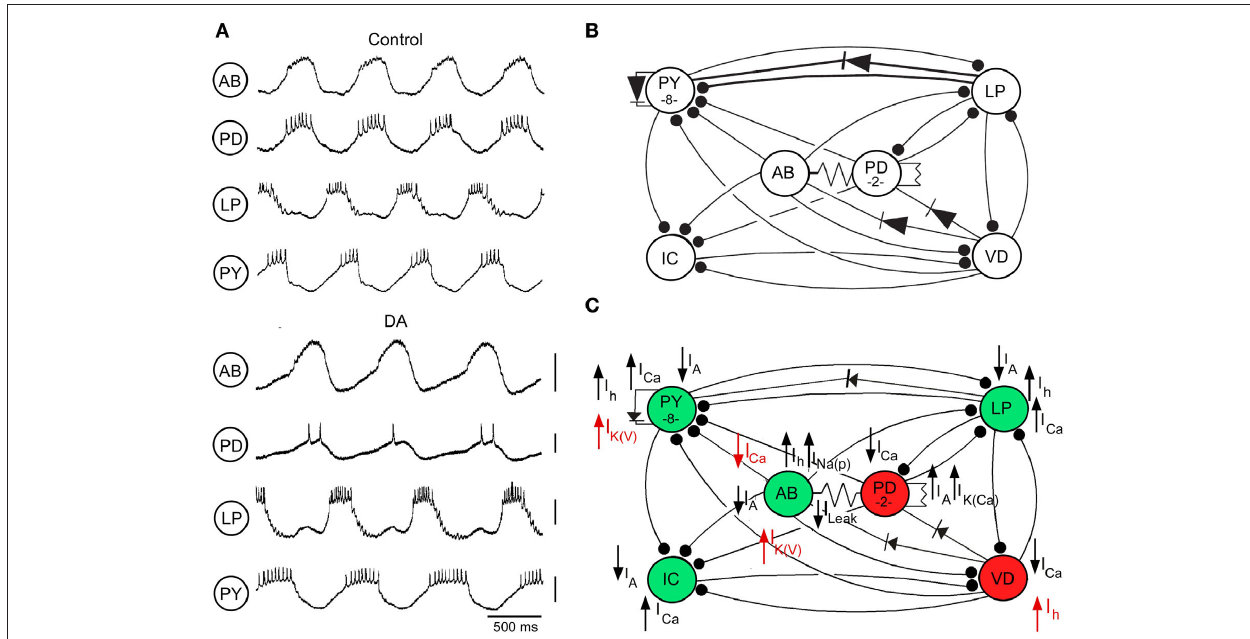
are electrical (non-rectifying, resistor symbols; rectifying, diode symbols) and chemical inhibitory (filled circles). (C) Known ionic current targets of DA in the pyloric neurons. Currents are strengthened (upward arrows) or weakened (downward arrows) by DA. Green and red neurons indicate enhanced and reduced excitability with DA. Currents in red act in opposition to the net effects of DA on the excitability of the different